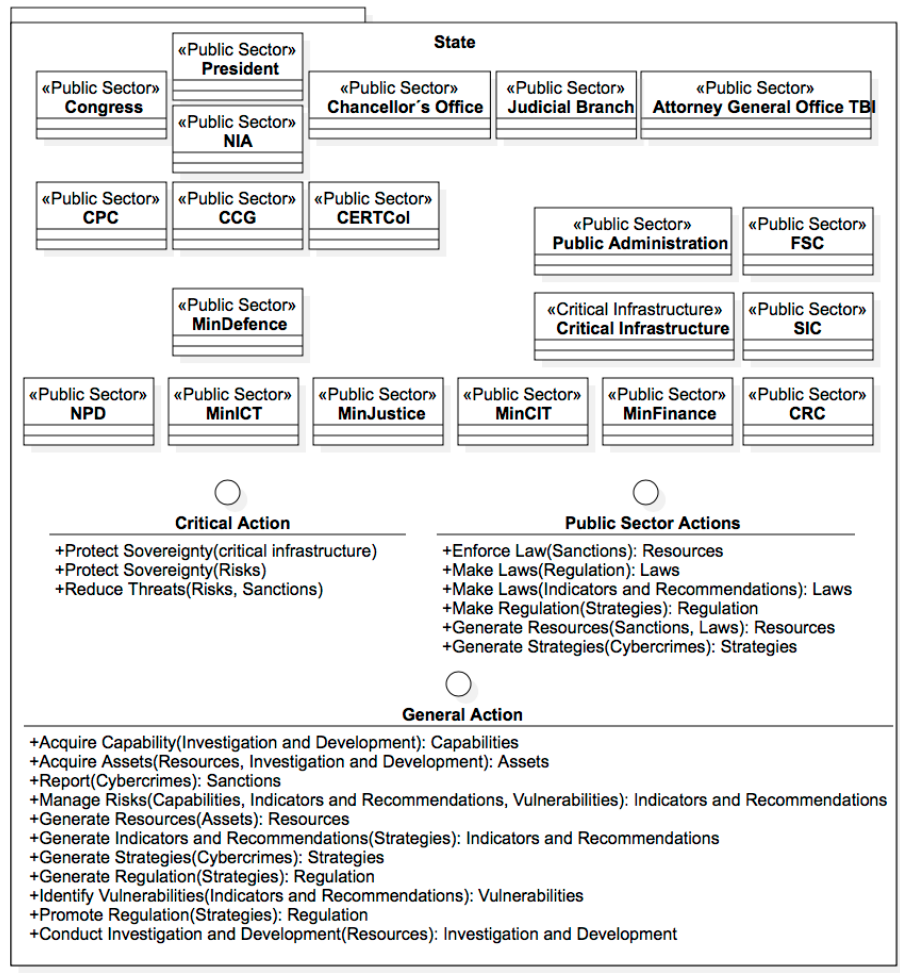
Figure 15. State Entities.